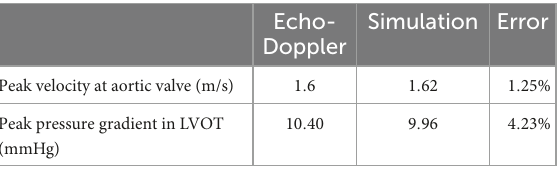
TABLE 3 VIM-1 model validation against Doppler-derived values.